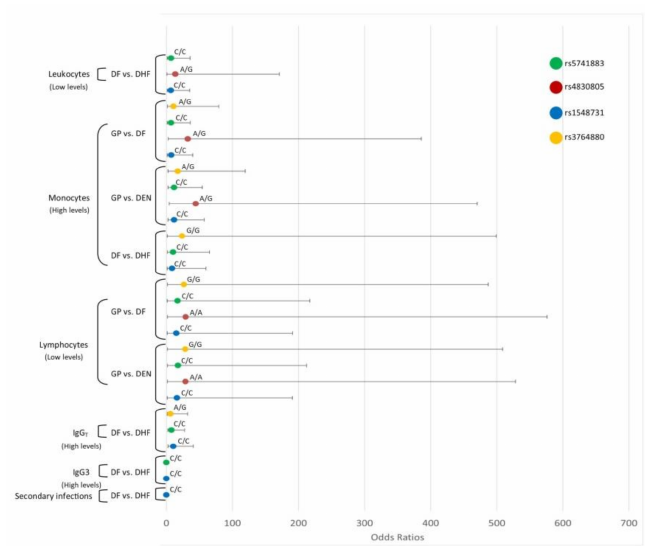
Figure 4. Interaction analysis of TLR 8 SNPs and the hematological covariates. Interaction analysis of TLR8 SNPs and the levels of hematological covariates leukocytes, lymphocytes, monocytes, and immunoglobulin levels total IgG, IgG3. Odds ratios and confidence intervals are shown in abscissa axis and genotypes are indicated above the odds ratios point.